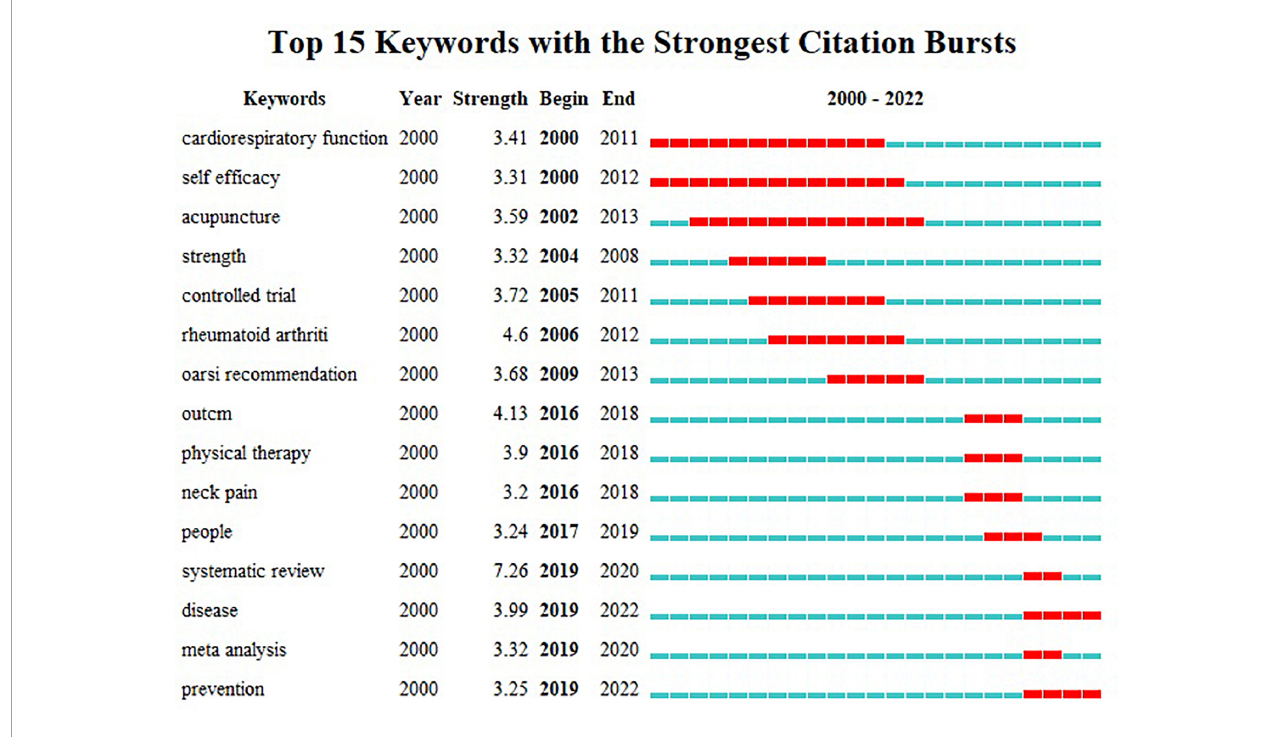
FIGURE6 Top 15 keywords with the strongest citation